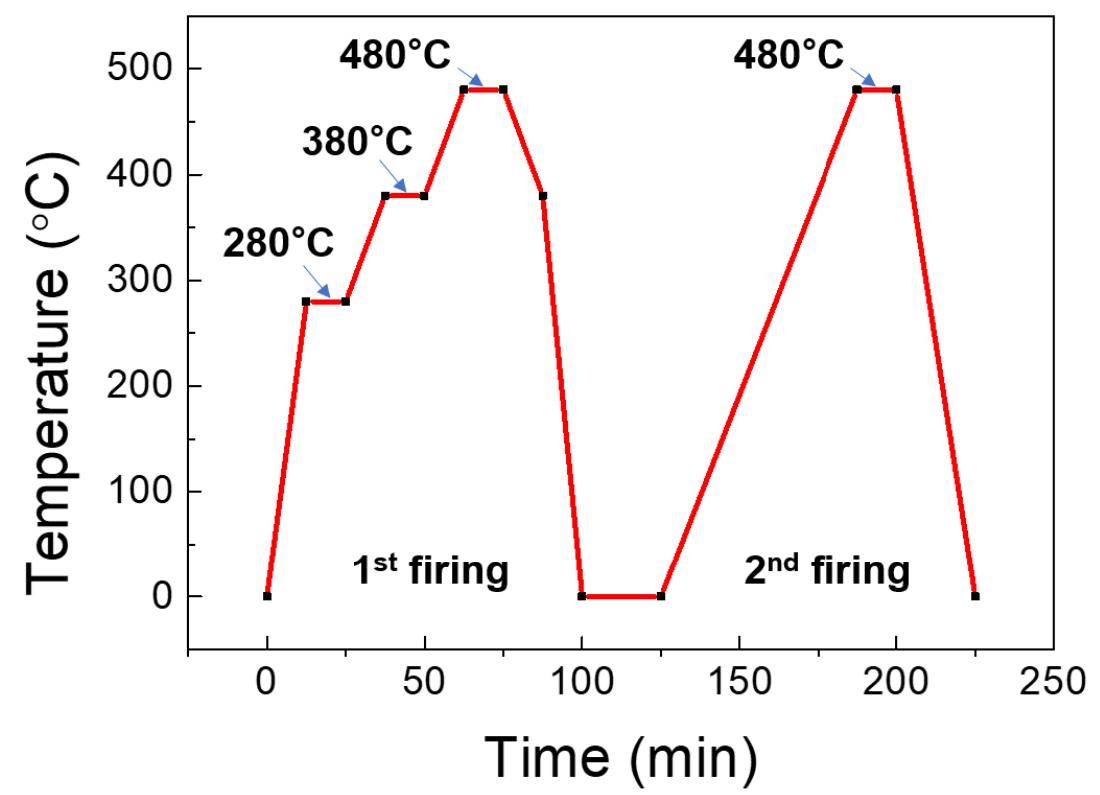
Figure 9. Temperature profile of the glass frit firing process.